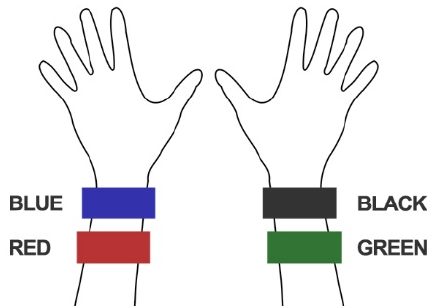
Figure 2. Activity monitor positions (color-coded for reference).